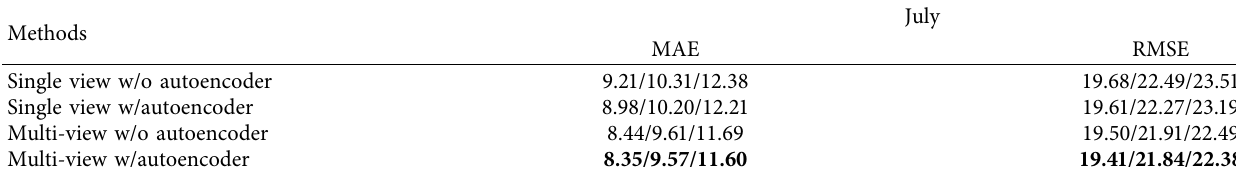
Table 3: Ablation contrast